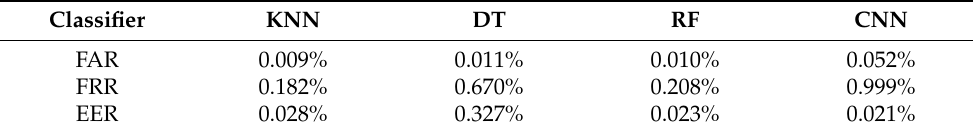
Table 9. CA evaluation—Scenario A (single mouse movement action): FAR, FRR, and EER.